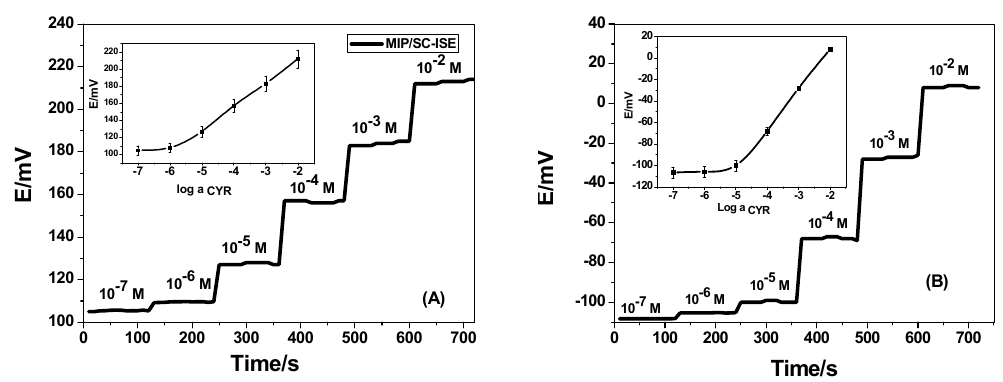
Figure 4. Potentiometric response curves of: ( A ) MIP / PANI-SCISE; and ( B ) TPB / CYR / PANI-SCISE in 50 mM acetate solution of pH 3.5. Table 1. Potentiometric characteristics of CYR sensors in 50 mM acetate solution of pH 3.5 .